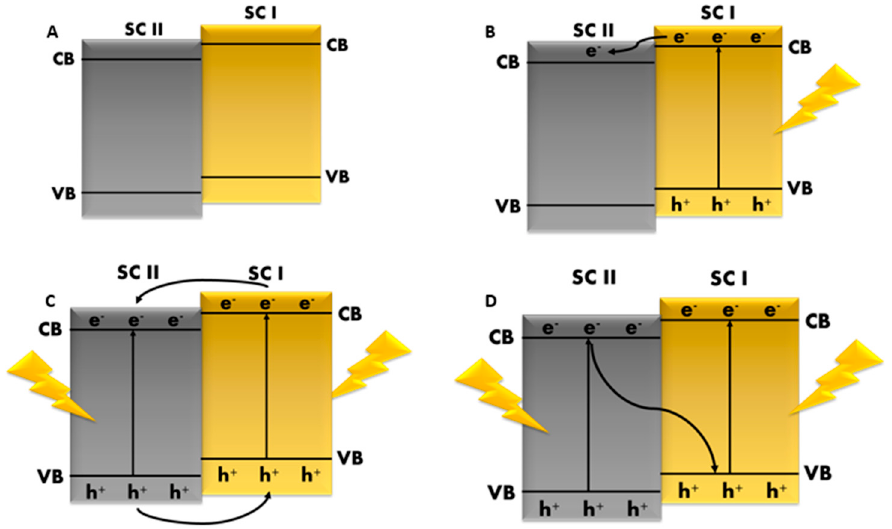
Figure 3. ( A ) Band structure of the SC–SC heterojunction. ( B ) Sensitization mechanism. ( C ) Type II heterojunction. ( D ) Direct heterojunction. ( D ) Direct Z-scheme.